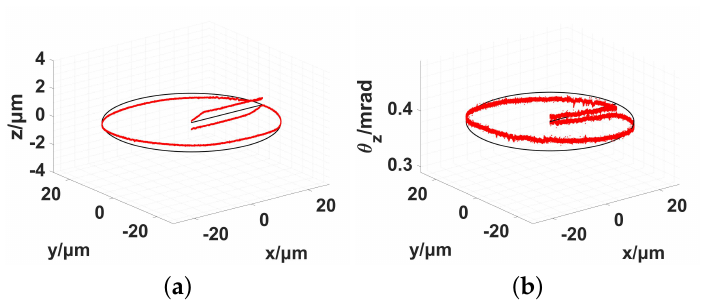
Figure 20. Measured trajectory during in-plane circle tracking. ( a ) x − y − z; ( b ) x − y − θ